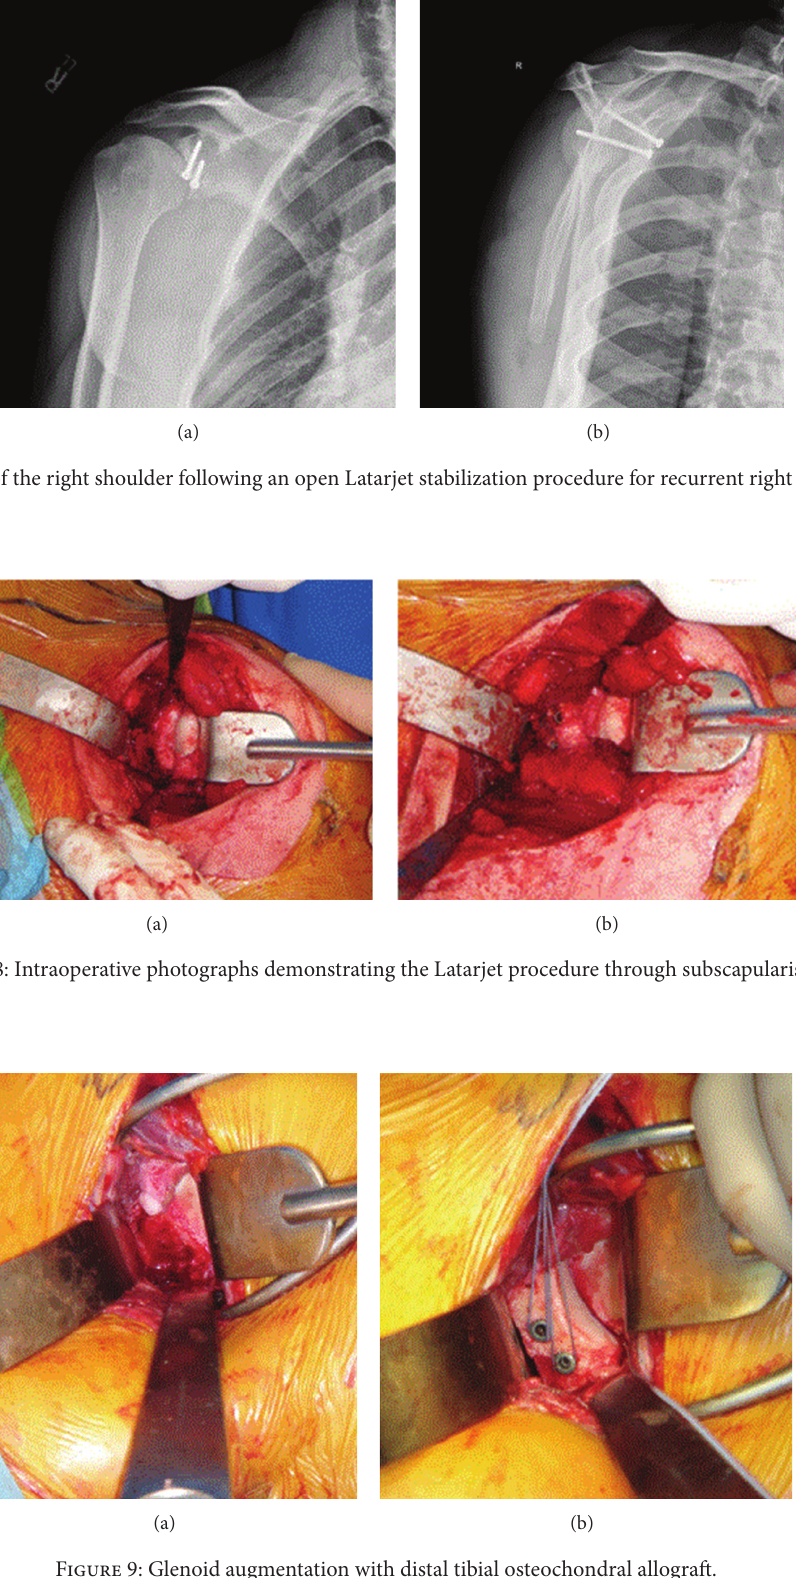
Figure 9: Glenoid augmentation with distal tibial osteochondral